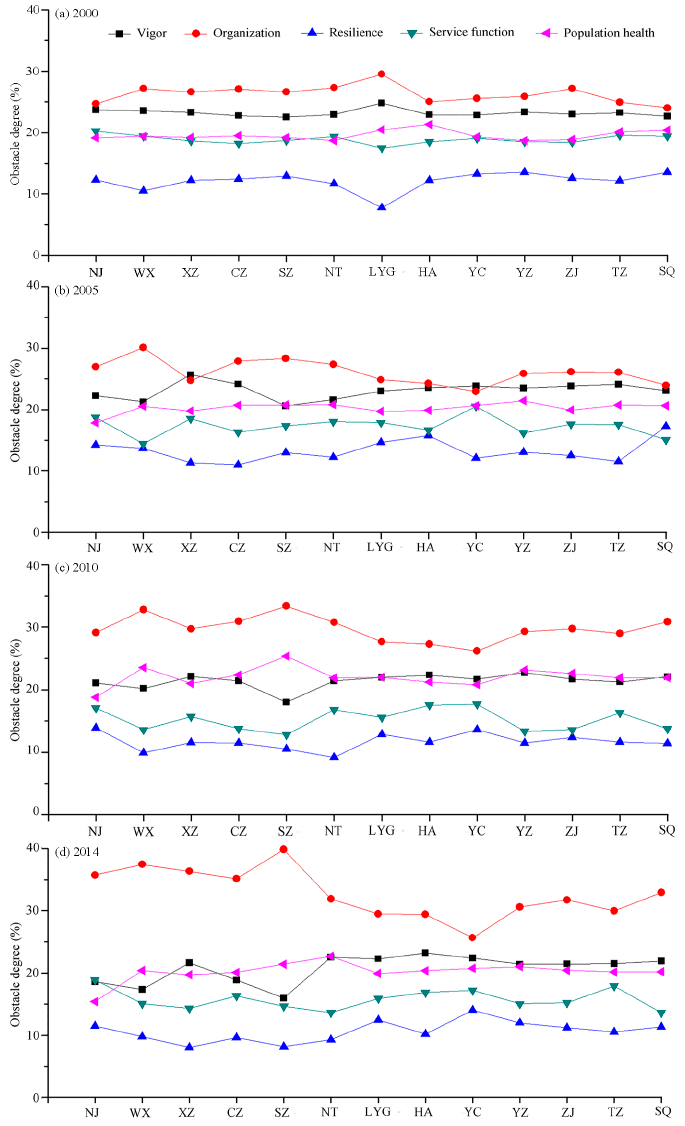
Figure 4. Obstacle degree of each component in different city from 2000 to 2014. (Line with different colors represents the obstacle degree values of different components of urban ecosystem health; NJ: Nanjing; WX: Wuxi; XZ: Xuzhou; CZ: Changzhou; SZ: Suzhou; NT: Nantong; LYG: Lianyungang; HA: Huai’an; YC: Yancheng; YZ: Yangzhou; ZJ: Zhenjiang; TZ: Taizhou; SQ: Suqian).